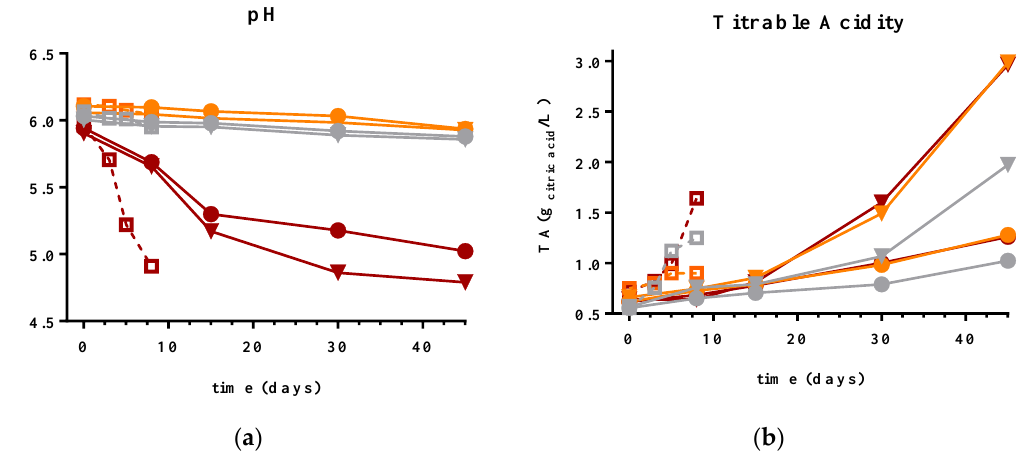
Figure 2 . Evaluation of the ( a ) pH and ( b ) titratable acidity in juices of O. ficus-indica versus storage time for non-pasteurized samples (raw ( □ )) and the two processing methods (high-pressure processing ( ● ) and thermal pasteurization ( ▼ )). Cv ´Rossa´ (red juice) in red ( ▬ ), cv ‘Gialla’ (orange juice) in orange, ( ▬ ) and cv ‘Bianca’ (white juice) in gray ( ▬ ). Results are expressed as averages ± SD.